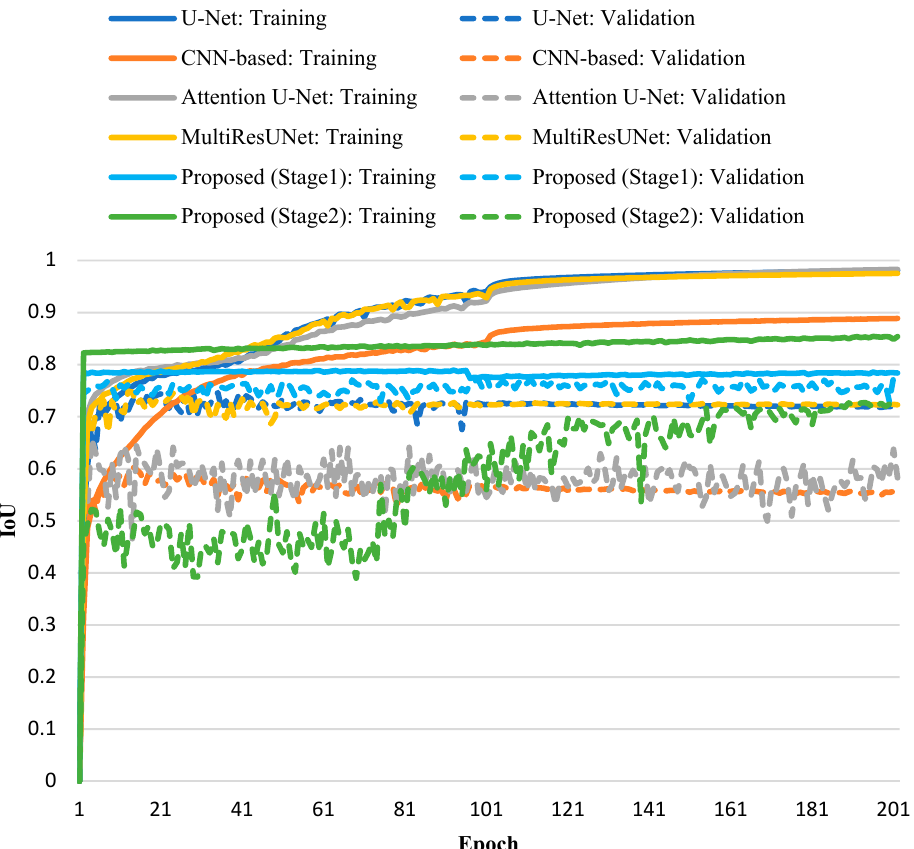
Figure 7. The curves of IoU during training and validation processes of different models: U-Net [9], CNN-based [10], Attention U-Net [11], MultiResUNet [12], and the proposed method (stage1 and stage2).